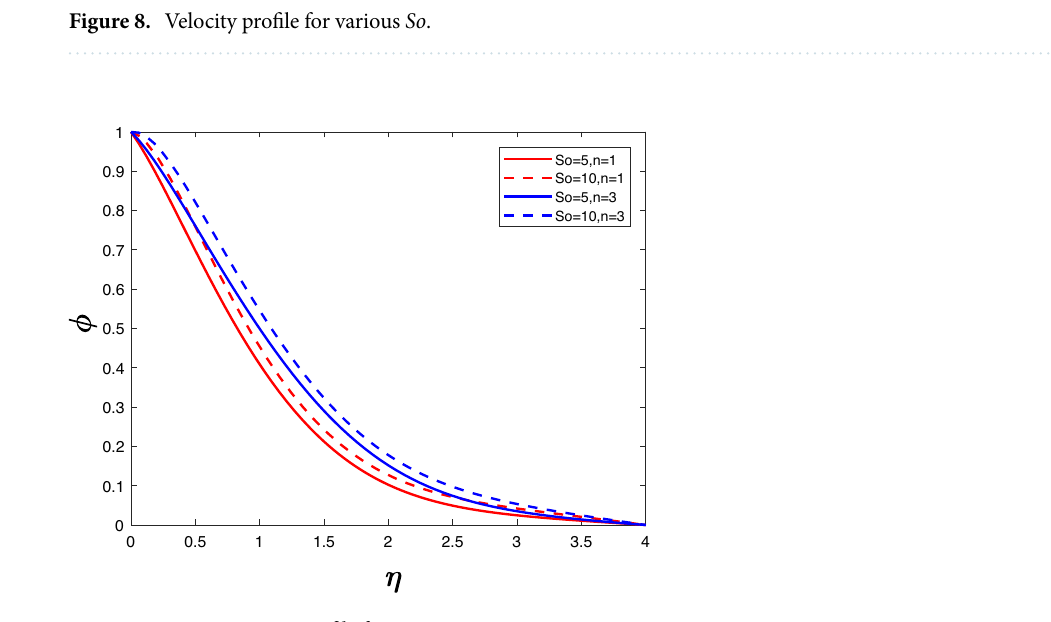
Figure 9. Concentration profile for various So .